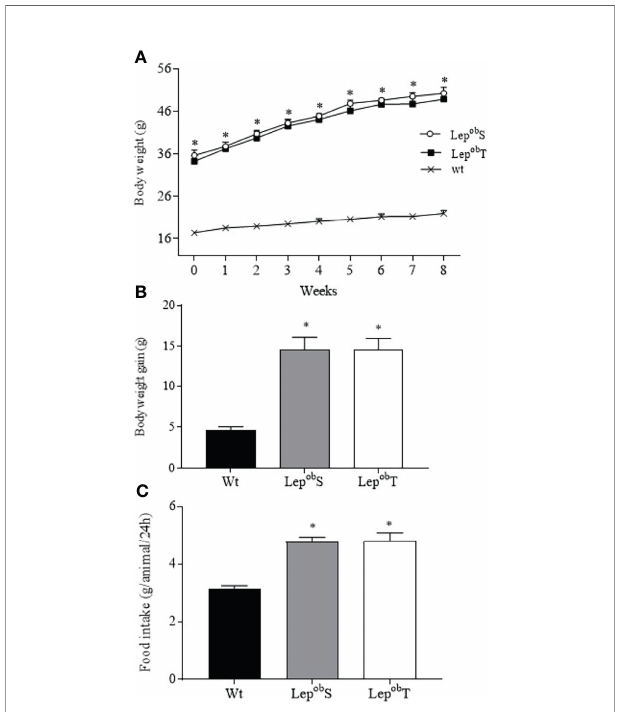
FIGURE 1 | Body weight evolution (A) , body weight gain (B) , and food intake (C) . Wt (n = 6), Lep ob S (n = 5) and Lep ob T (n = 8). Error bars indicate the SEM. *p ≤ 0.05 vs. Wt. The results of body weight evolution were compared by two-way ANOVA and body weight gain and food intake by one- way ANOVA plus Tuckey post hoc